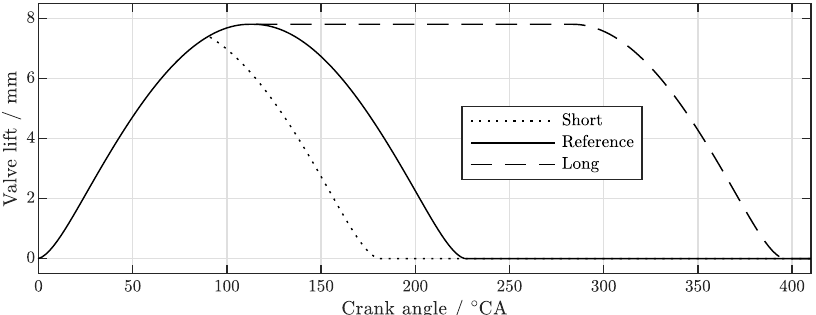
Figure 3. Illustration of the valve timing set up. Valve lifts are adjusted according to the stroke length based on the valve lift curve of the reference